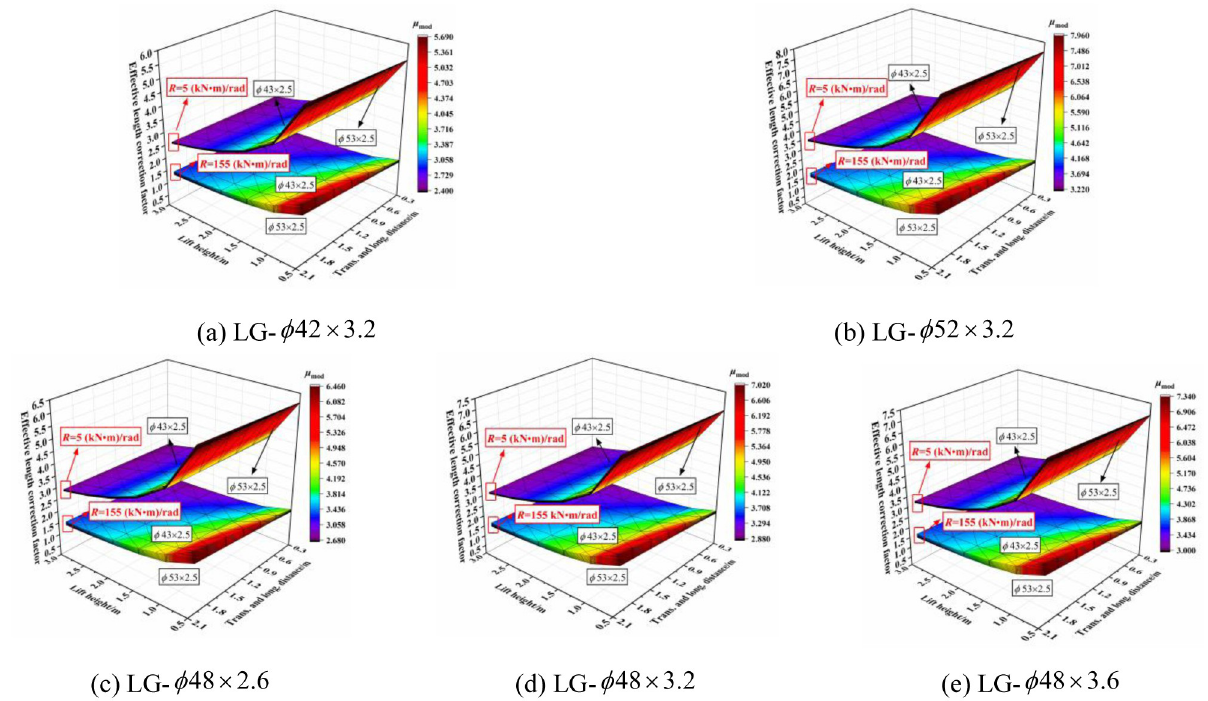
Fig 22. Three-dimensional diagrams of the influence of the outer diameter size of the horizontal bar section on the effective length correction factor. (a) LG- ϕ 42 × 3.2. (b) LG- ϕ 52 × 3.2. (c) LG- ϕ 48 × 2.6. (d) LG- ϕ 48 × 3.2. (e) LG- ϕ 48 × 3.6.